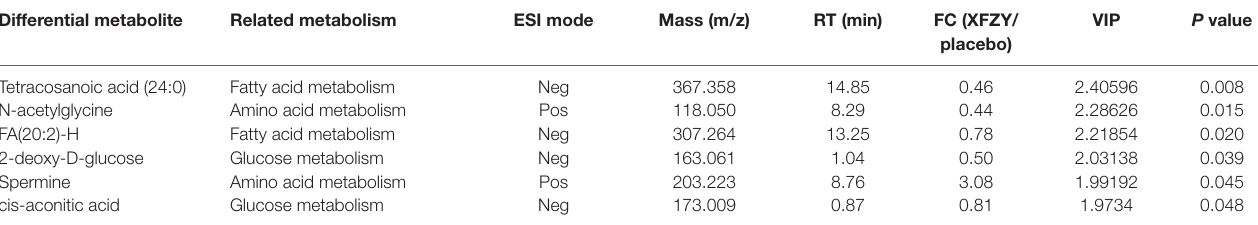
TABLE 3 | Differential metabolites between the XFZY group and placebo group patients from LC-MS/MS analysis. Differential